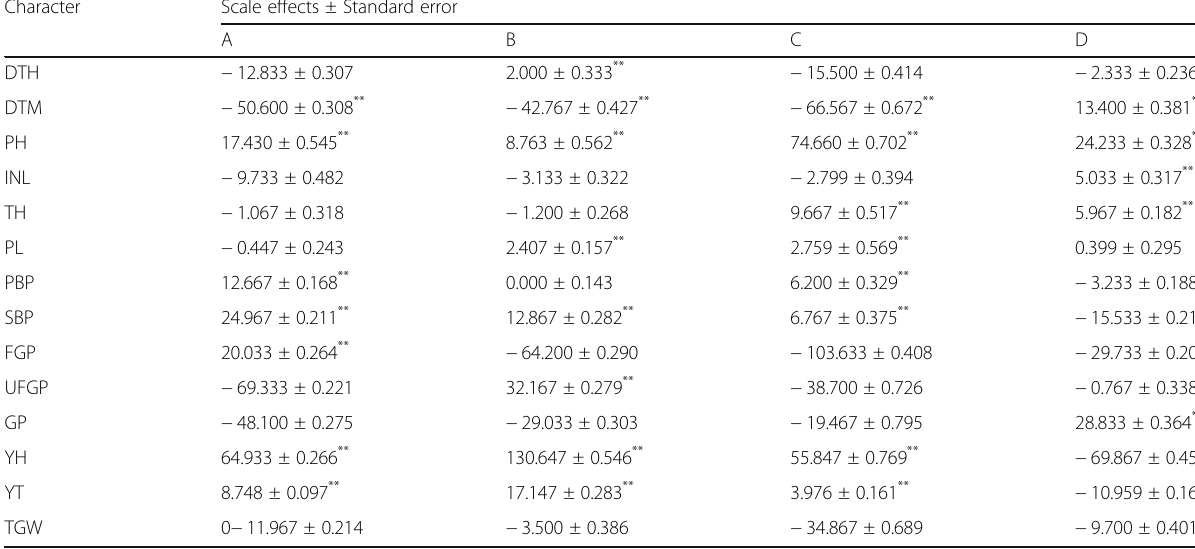
Table 3 Scale estimation of different traits in submergence tolerant rice